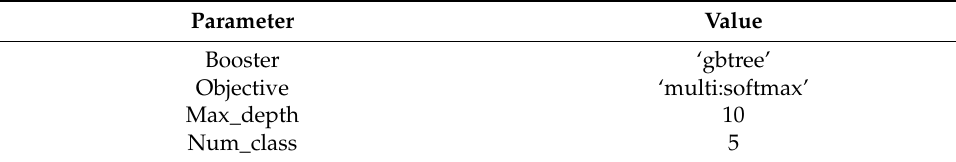
Table 4. XGBoost Parameter.